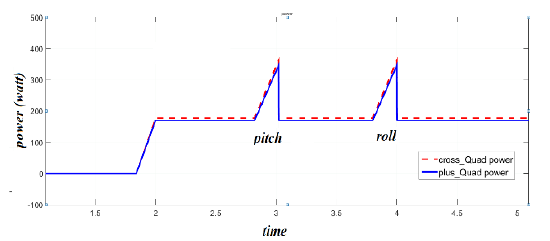
Figure 16. Cross-quadcopter yawing response